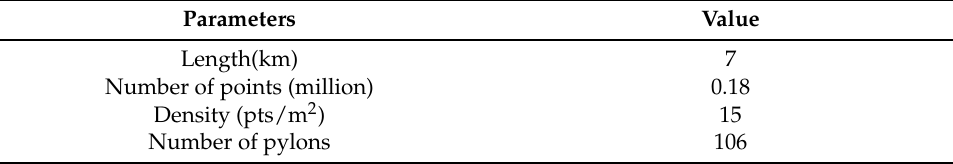
Figure 12. The railway dataset used by the proposed method. Table 2. Descriptions of the dataset.